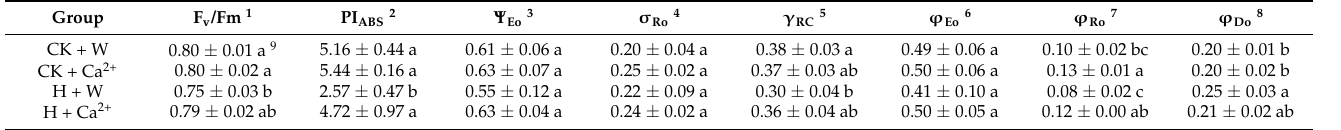
Table 3. Parameters derived from prompt chlorophyll a fluorescence transients in the leaves of Rhododendron × pulchrum under the four treatments.